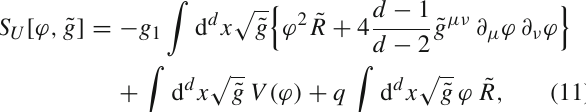
isomorphic, so the natural question is whether they actually are the same physical model or not. From the Hamiltonian analysis emerges that the two models propagate the same degrees of freedom [25], so it is fair to say that classically the Einstein’s and unimodular-dilaton gravitational models are equivalent. What is less clear is if the two models